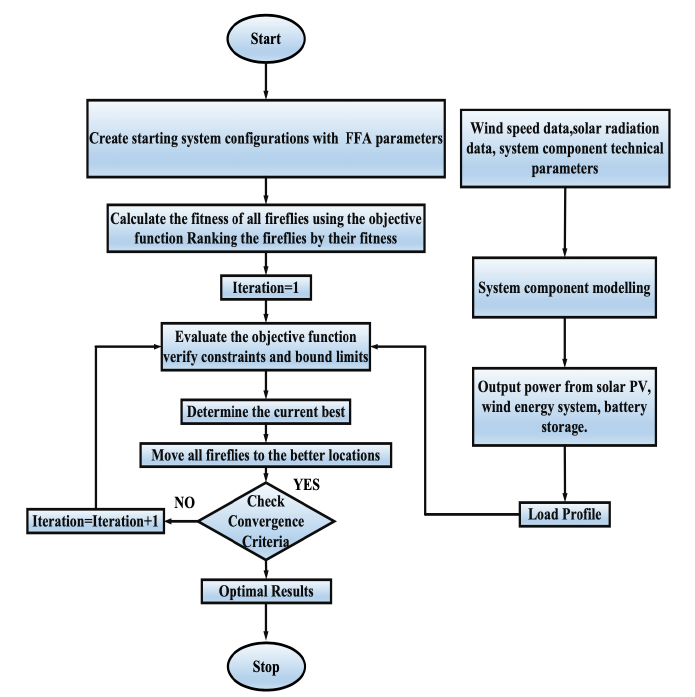
Fig. 3. Flow chart Fire-Fly